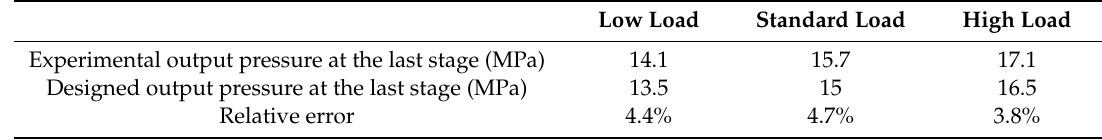
Table 12. Comparison between the experimental results and the designed values.